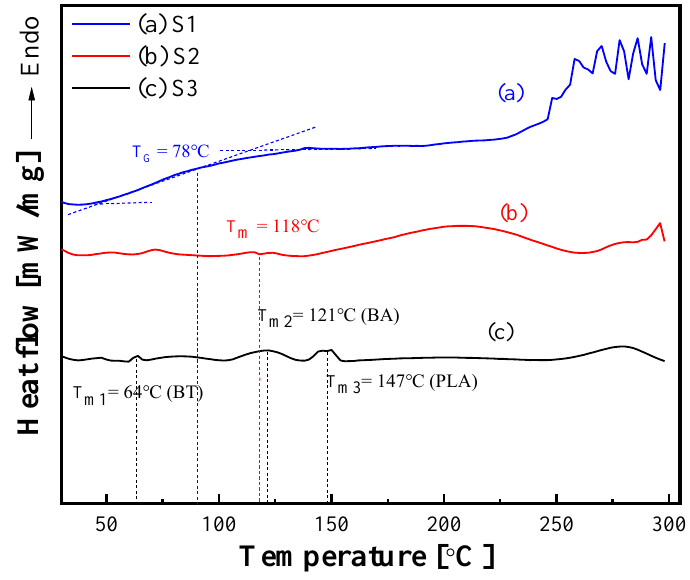
Figure 3. DSC curves of ( a ) S1, ( b ) S2, and ( c ) S3. The melt rheological properties of the samples were examined by first performing a temperature sweep test at a heating rate of 4 °C/min with a strain of 1% and an angular frequency of 6.28 rad/s. After checking melting temperature (Tm) by the temperature sweep test, the strain amplitude test and steady shear test were performed under various temperature conditions around the Tm temperature. Figure 4a presents the storage modulus (G ′ ) and loss modulus (G ″ ) of S1 in the temperature range of 140 °C to 220 °C, where G ′ is always greater than G ″ , which proves that S1 is a solid-like state in the entire temperature range without melting. Figure 4b shows the G ′ and G ″ as a function of strain with a constant angular frequency of 6.28 rad/s at 160, 170, 180, and 190 °C. A linear viscoelastic (LVE) region appears in the low-strain area, and G ′ > G ″ , demonstrating the solid-like state of S1. On the other hand, as the strain increases, the sample structure is destroyed, the modulus decreases rapidly, and a crossover point appears, after which G ″ > G ′ . Moreover, the modulus decreases as the temperature is increased, which proves that the material gradually softens, and the sample begins to thermally degrade and no longer softens when the temperature is increased to 190 °C.